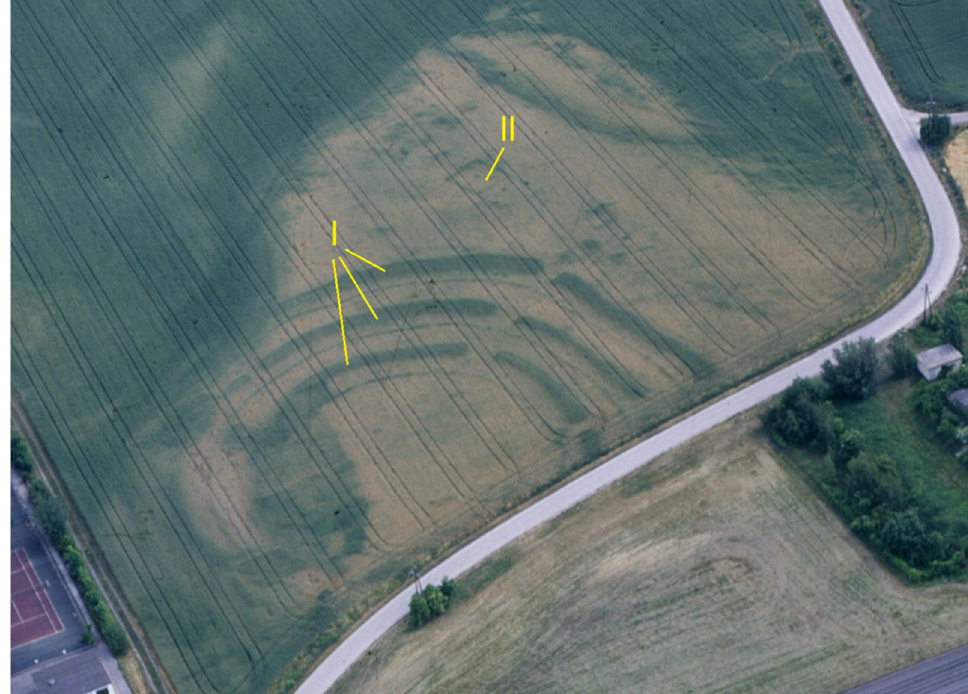
Figure 5. Oblique aerial photograph from June 2001 showing positive vegetation marks of the KGA’s ditches and palisades as well as remains of at least one building. The Roman numerals refer to the archaeological interpretation noted in the text. I—the three ditches of the KGA, II—building (Luftbildarchiv, IUHA, Universität Wien, No.: 0120010603.050). The vertical image pair had an overlap of 60%, which facilitated a photogrammetric aerial photo analysis. This was realized in 2004. At that time, both analytical and digital methods were used. To create a digital terrain model (DTM) of the area, the vertical stereopair was oriented using the analytical plotter DSR14 (KERN-WILD-LEICA) with control point information, which had been measured in the field by a total station. The DTM was measured in the form of a regular raster of 3D terrain points accompanied by 3D break line information (see also [20]). Both digitized vertical images and oblique photographs were then orthorectified using ERDAS Imagine Orthobase. The resulting orthophoto has